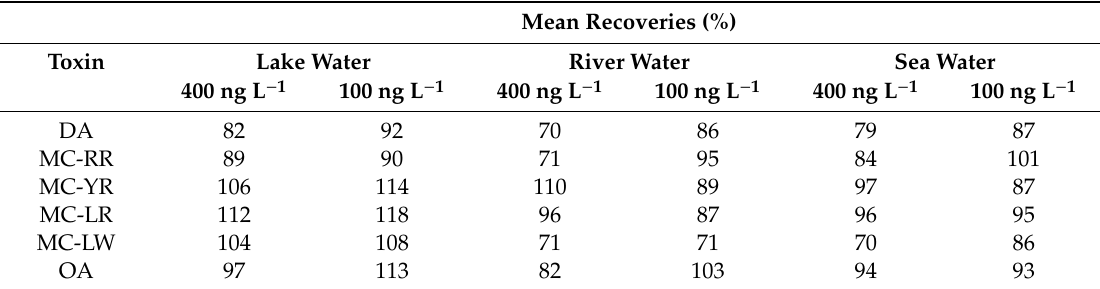
Table 1. Mean recovery (%) in the water samples ( n = 3). Mean Recoveries (%) Lake